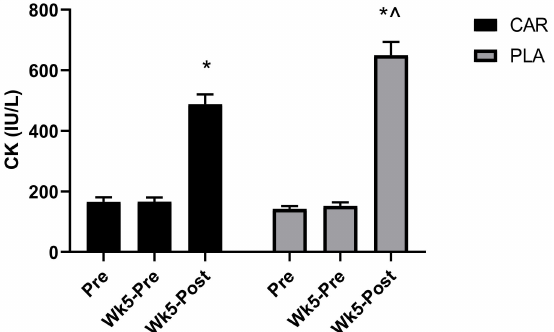
Figure 2. Serum creatine kinase (CK) concentration. Mean values and error bars for the standard error of the mean for concentration values of serum creatine kinase (CK) are shown. * indicates a significant difference between the time point Pre and Wk5-Post ( p < 0.001). ˆ indicates a significant difference between groups ( p < 0.05). The groups are carnitine (CAR) and placebo (PLA).